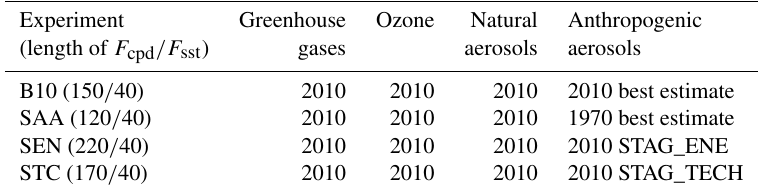
Table 1. Overview of the fully coupled ( F cpd ) and the paired simulation ( F sst ) where sea surface temperature and sea ice are fixed. They are the baseline 2010 (B10) simulation, fixing aerosol-related emissions in 1970 levels (SAA), stagnation of anthropogenic aerosol-related emissions from energy use in 1970 levels (SEN), and stagnation of aerosol-related emissions related to technology and abatement measures in 1970 levels (STC). All F cpd simulations are run until equilibrium (numbers in brackets denote the lengths of model integrations in years), while all F sst runs are integrated for 40 years. Only the last 30 years of each F cpd /F sst run is used for analysis. Note the difference in the integration lengths of F cpd simulations, which is determined on the criterion that the top-of-the-atmosphere radiation imbalance no longer shows significant trends (stabilizing at around ∼ 0 . 3Wm − 2 in this case) during the last few decades of each run (see the main text). The responses to the 1970–2010 anthropogenic aerosol-related emissions are given as the following: Best Estimate = B10–SAA; energy-use growth = B10–SEN; and technology advances = B10–STC. Experiment Greenhouse Ozone Natural